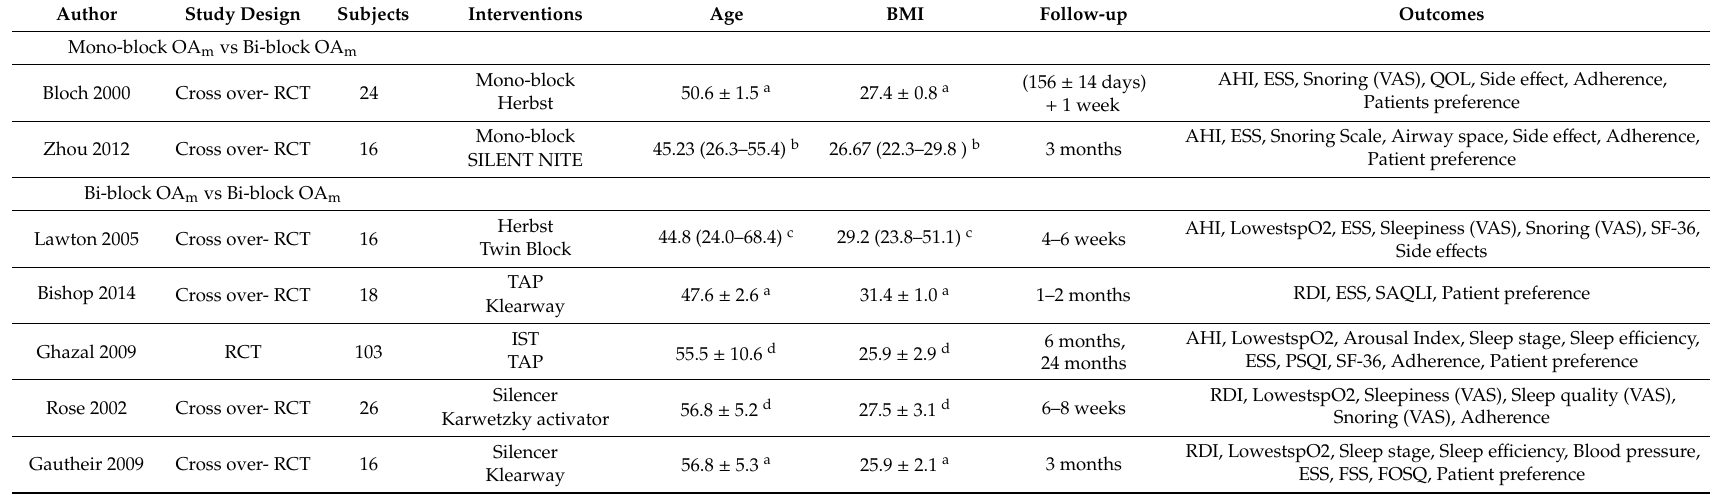
Table 1. Characteristics of the included studies for systematic